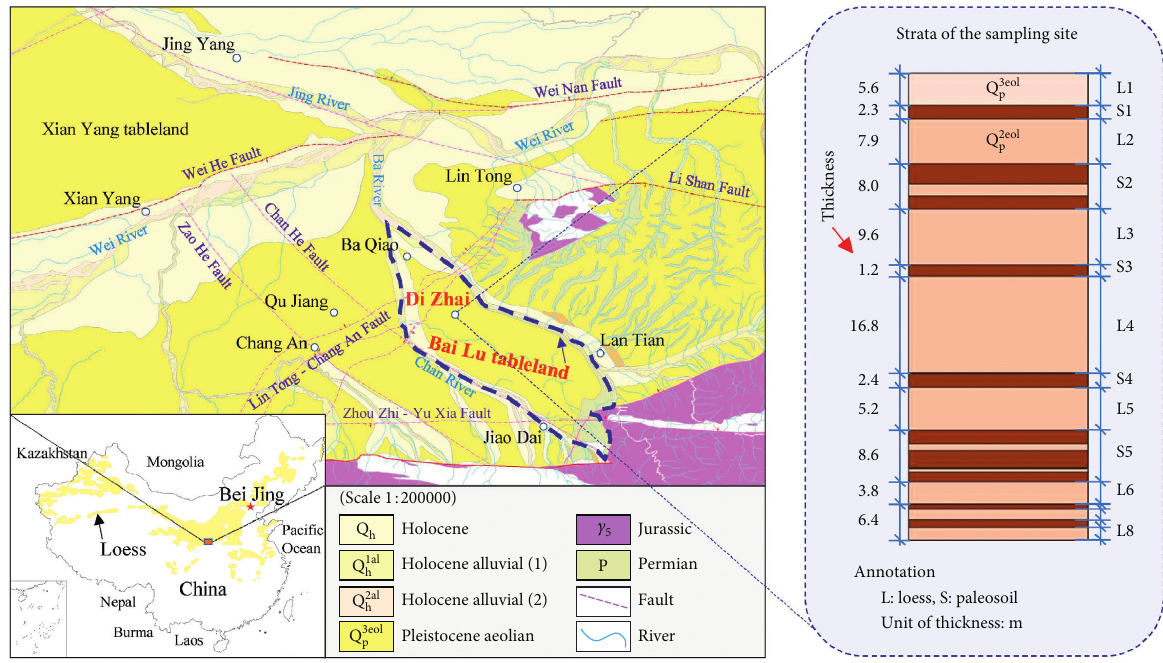
Figure 1: Location and geological condition of the study area.